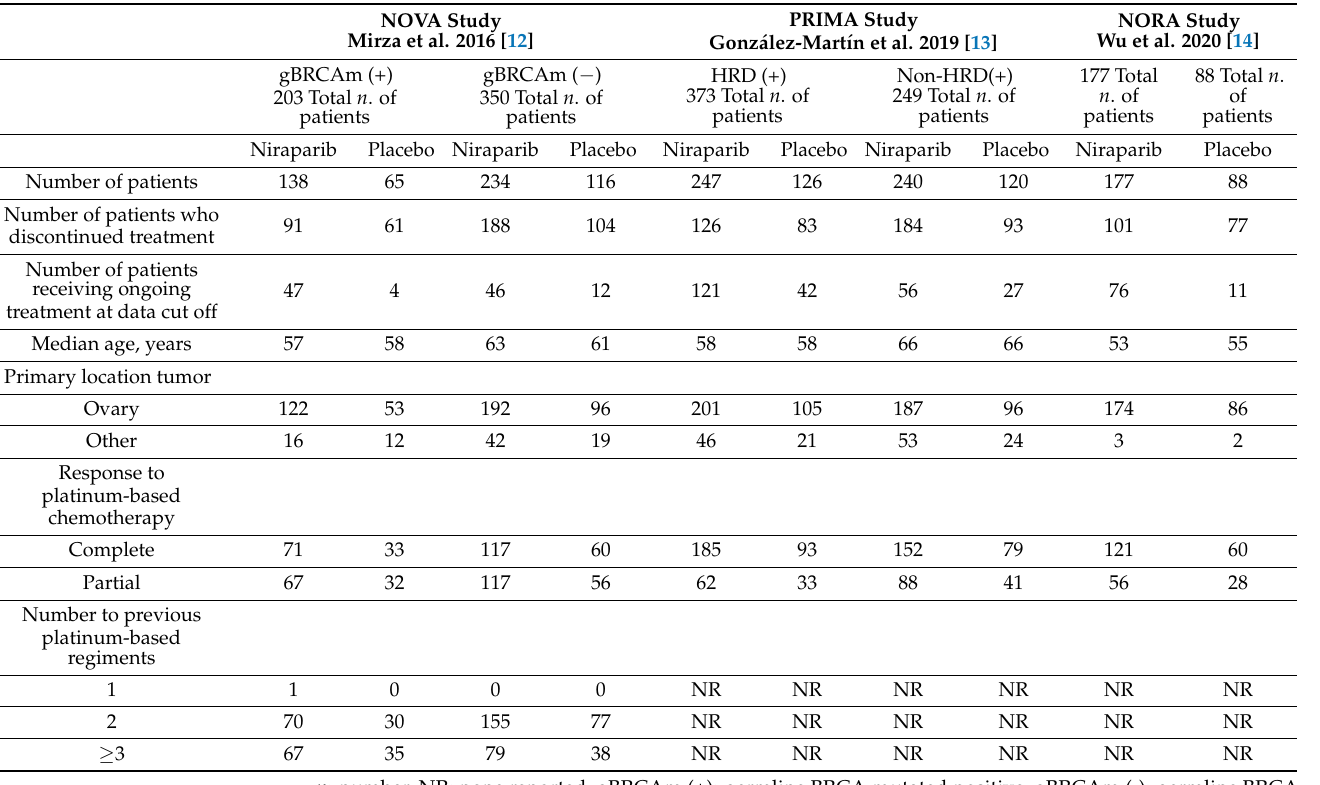
Table 1. Baseline